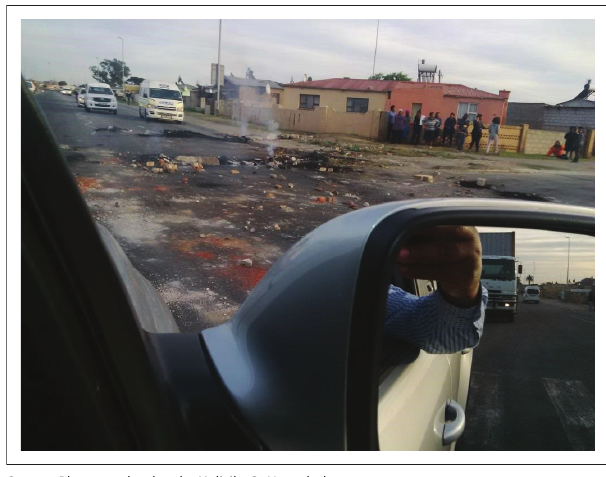
FIGURE 2: Service delivery protest at Nelson Mandela